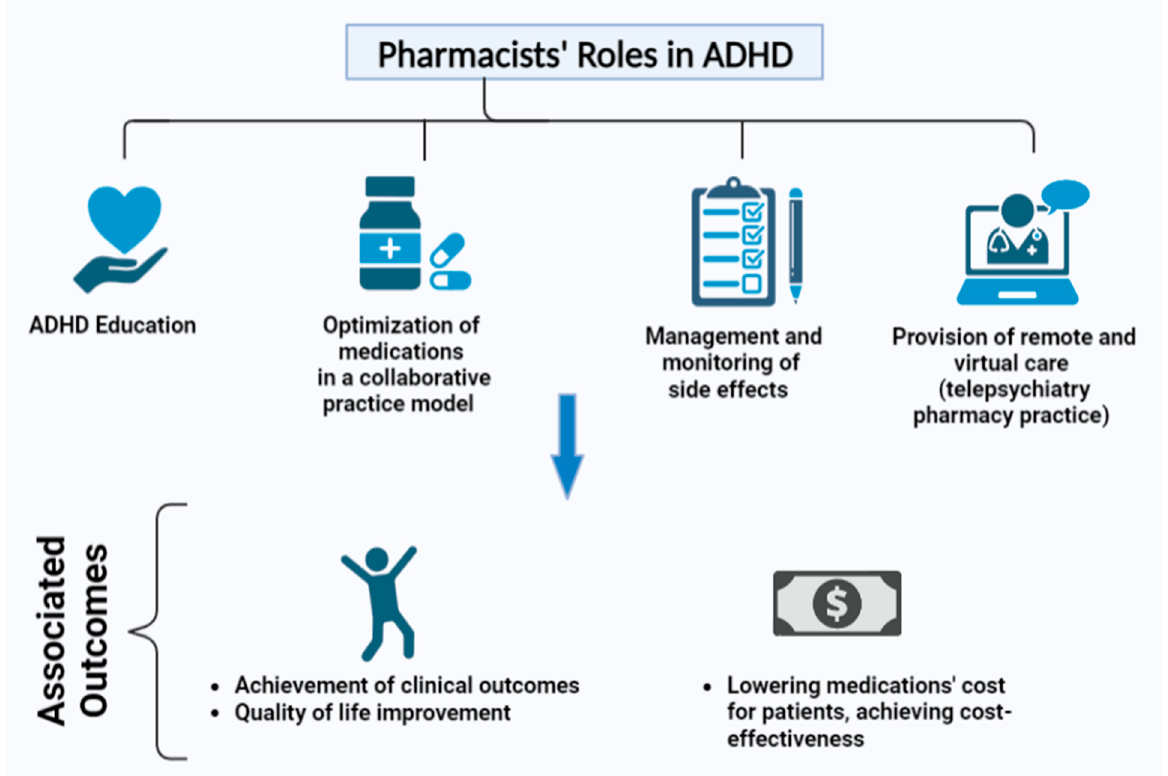
Figure 1. Pharmacists’ roles and associated outcomes in